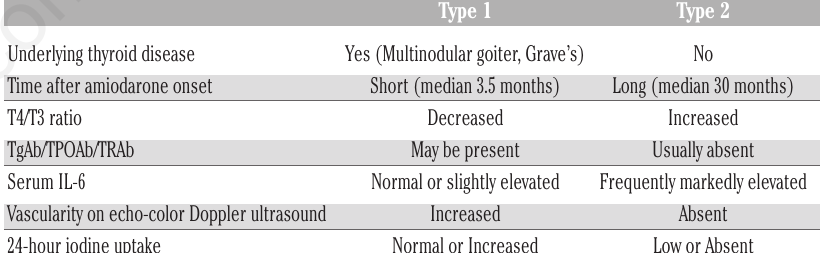
Table 2. Differences between type 1 and 2 amiodarone-induced thyrotoxicosis.